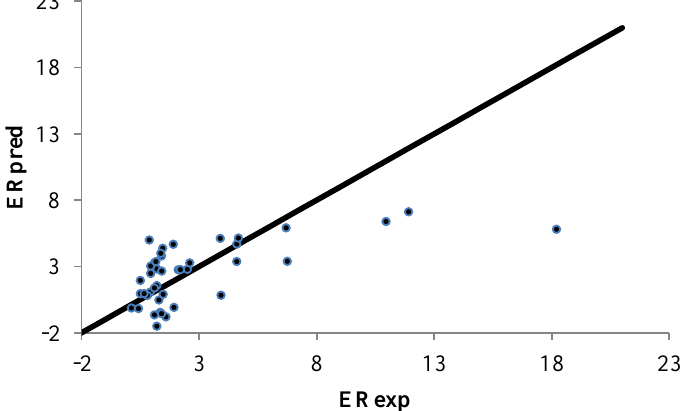
Figure 3. Correlation between the linear predicted and experimental ER for the set of 42 polar CPEs from DB #2. The enhanced replacement method (ERM) was applied for the selection of the descriptors.